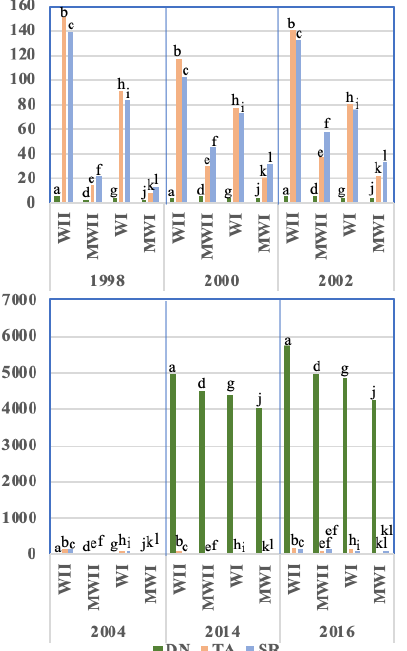
Figure 4. Average values of the Water Impoundment Index (WII), Modified Water Impoundment Index (MWII), Water Index (WI), and Modified Water Index (MWI) of deep water for three pre-processing levels (DN, TA, SR) across six years. Letters denote significant difference (p <0.05) between pre- processing levels within a given index. Average index values for pre-processing levels were not compared across different